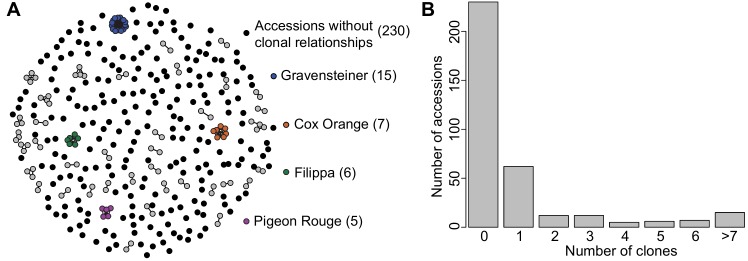
Clonal relationships in the Danish apple germplasm collection.(A) Network of clonal relationships among 349 Malus domestica accessions. Each accession is represented by a dot. Accessions without a clonal relationship to other accessions are indicated with a black dot. Accessions with four or fewer clonal relationships are shown in grey together with their clones. Accessions with five or more clonal relationships are indicated by a colour code. (B) For each of the 349 accessions, the number of clonal relationships was evaluated. The majority of accessions (230) are without clonal relationships while 119 (34%) of the accessions have clonal relationships with one or more accessions.